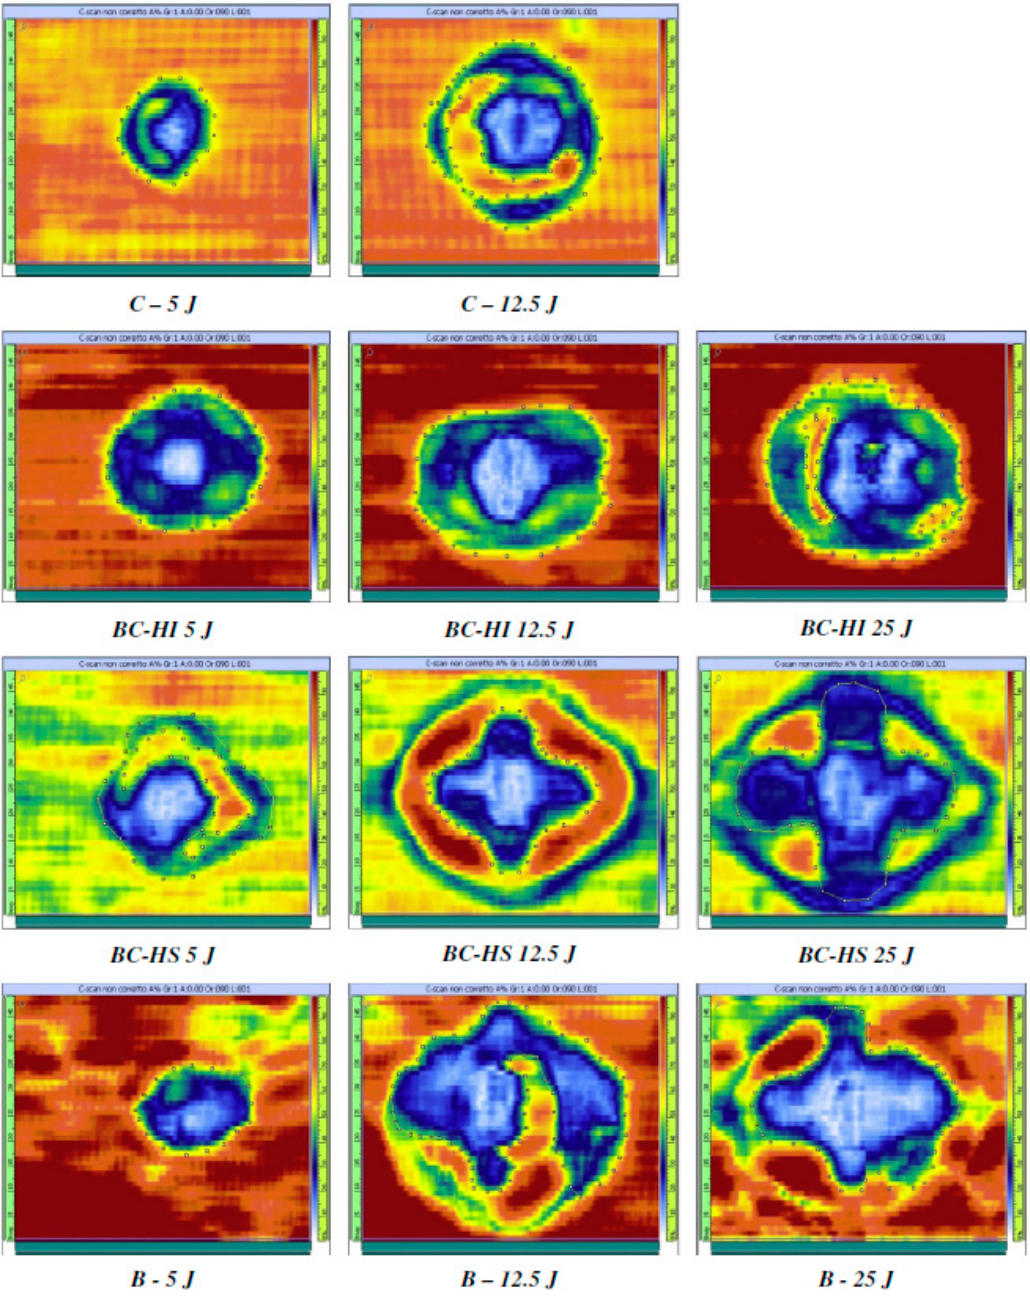
Figure 9. The C-Scan images of the impacted sandwich and intercalated carbon–basalt hybrid laminates compared with the pure carbon and pure basalt laminates at different energies (redrawn from an image supplied by authors of [18]).